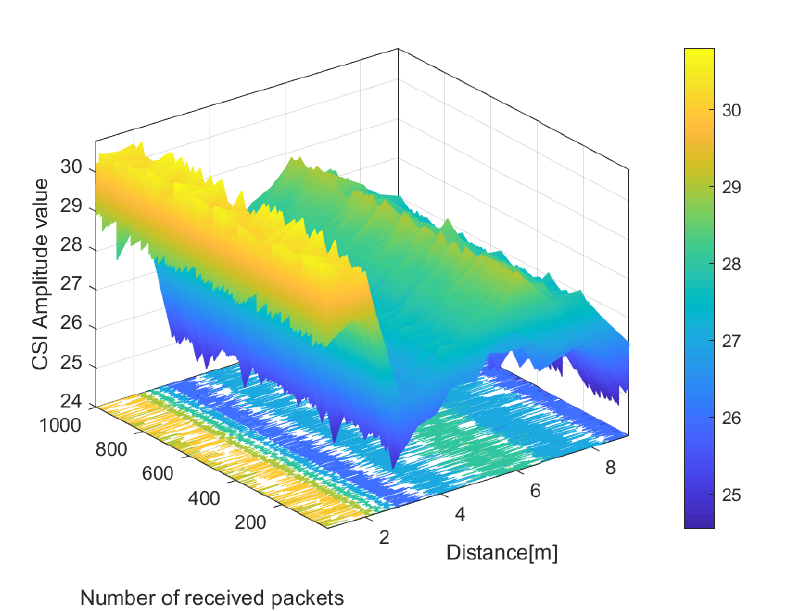
Figure 14. 3D graph of CSI effective value attenuation with distance in IT-1